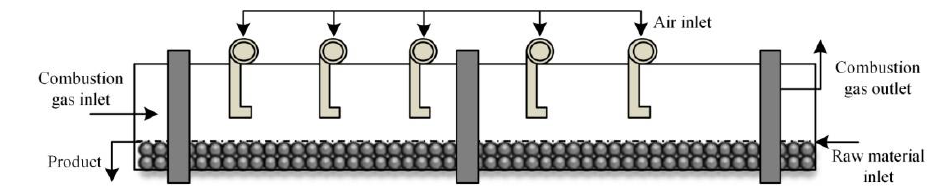
Figure 1. Schematic diagram of the pre-reduction rotary kiln.